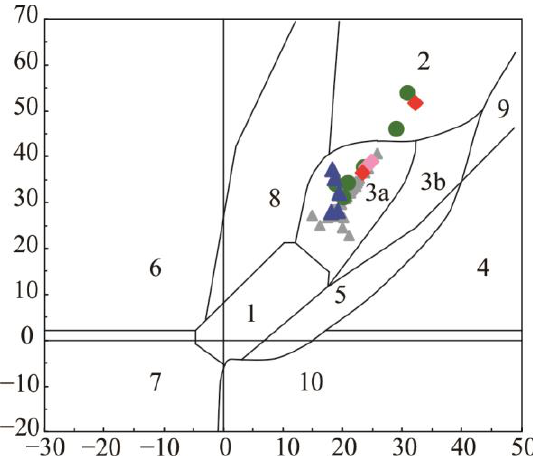
Figure 13. Δγ–Δβ diagram for genetic classification according to Pb isotope compositions of the Hutouya deposit ([94]; 1—mantle-derived lead; 2—upper crust lead; 3—mixed lead of upper crust and mantle subduction (3a. magmatism; 3b. sedimentation); 4—chemical sedimentary lead; 5—submarine hydrothermal lead; 6—medium–high grade metamorphism lead; 7—lower crust lead of high grade metamorphism; 8—orogenic belt lead; 9—upper crust lead of ancient shale; 10—retrograde metamorphic lead).